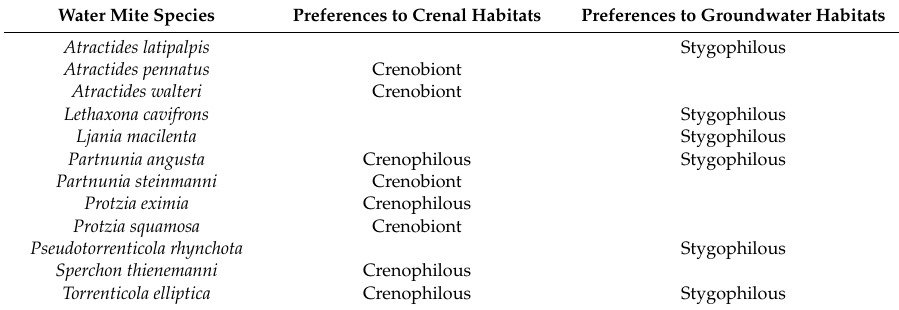
Table 1. List of water mite species with determined ecological preferences (synecological groups) to crenal and groundwater habitats. Ecological preferences were determined using literature data from [18–20].